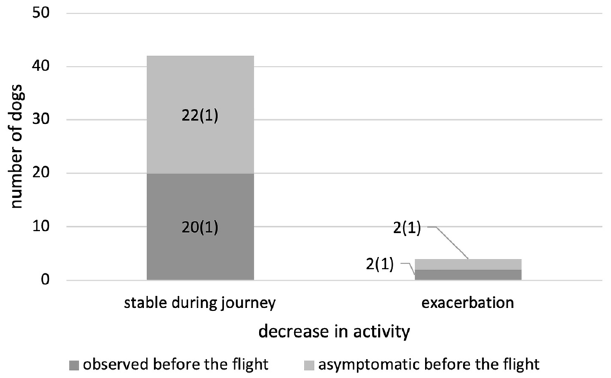
Figure 1. Decrease in activity status during the journey. The majority of dogs showed no changes in activity compared to the status before the flight. Numbers in parentheses represent the number of dogs diagnosed with cardiac events shortly after